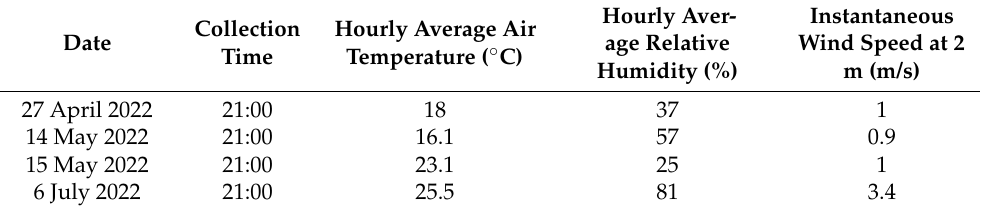
the Pantelleria meteorological station at Madonna delle Grazie (Longitude: 11.953109,